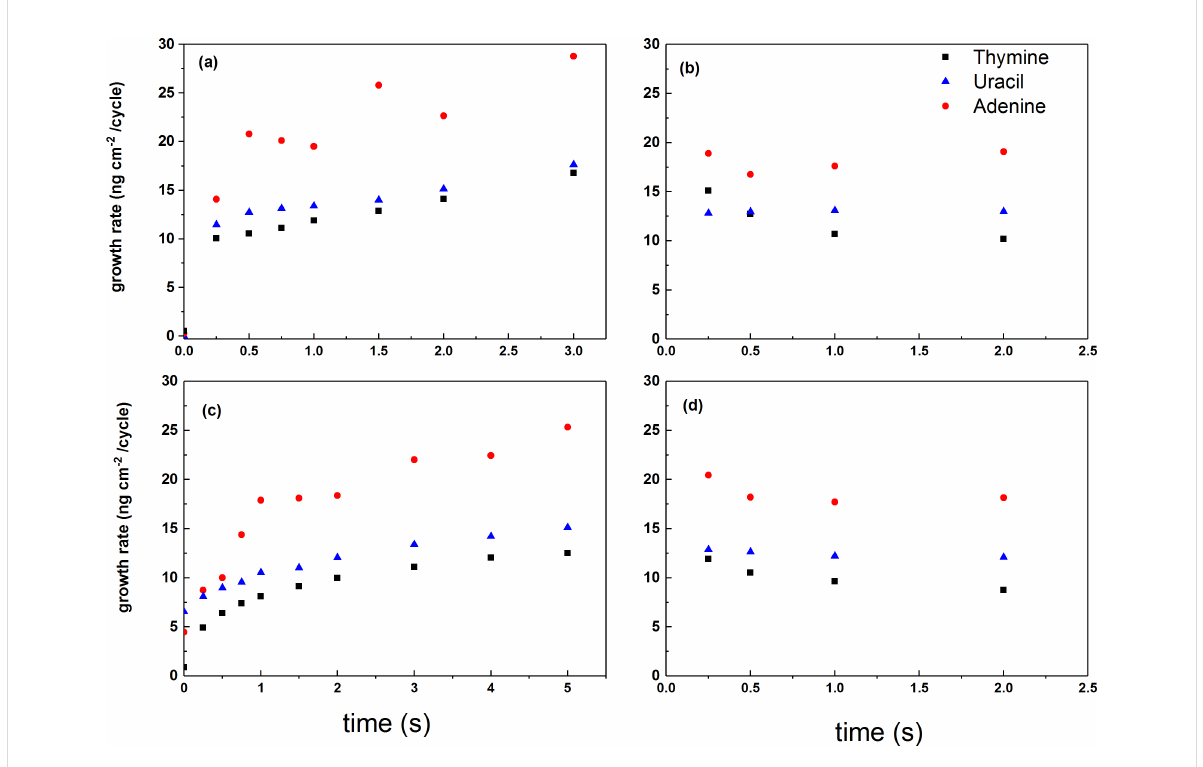
Figure 2: The growth rate of the QCM systems as function of (a) length of TTIP pulse, (b) TTIP purge, (c) organic precursor pulse (thymine – black square, uracil – blue triangle, adenine – red circles), and (d) organic precursor purge.